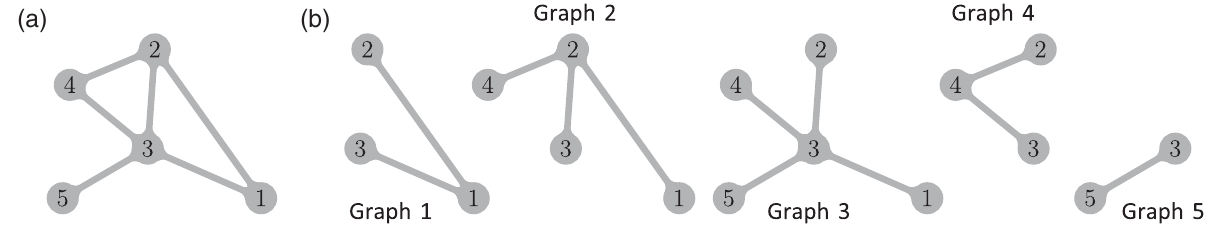
FIG. 11. Network decomposition into starlike subgraphs. (a) Full graph with five network states. (b) All five starlike subgraphs. The set of neighboring states contains N 1 ¼ f 2 ; 3 g , N 2 ¼ f 1 ; 3 ; 4 g , N 3 ¼ f 1 ; 2 ; 4 ; 5 g , N 4 ¼ f 2 ; 3 g , and N 5 ¼ f 3 g